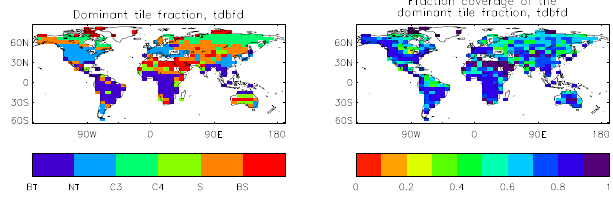
Fig. 2. The left-hand figure shows the simulated dominant plant functional type for the best performing land surface ensemble mem- ber and the right-hand figure shows the fractional coverage of the dominant type.